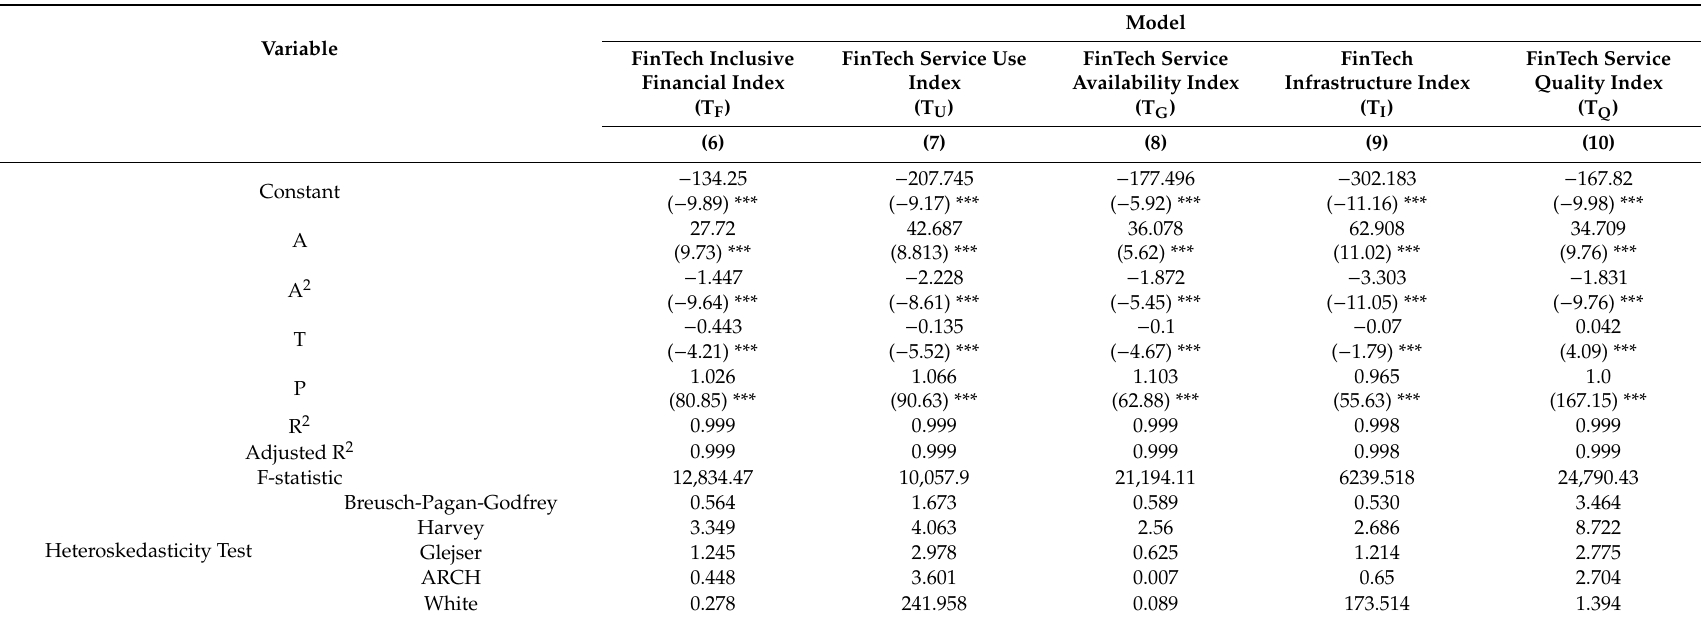
Table 3. Estimation results of the improved STIRPAT